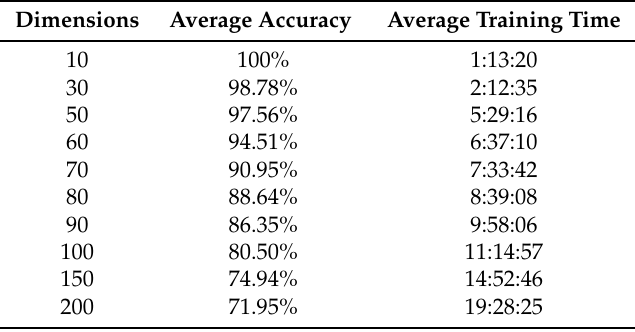
Table 1. Average accuracies and training times for Max-cut problems with different dimensions by